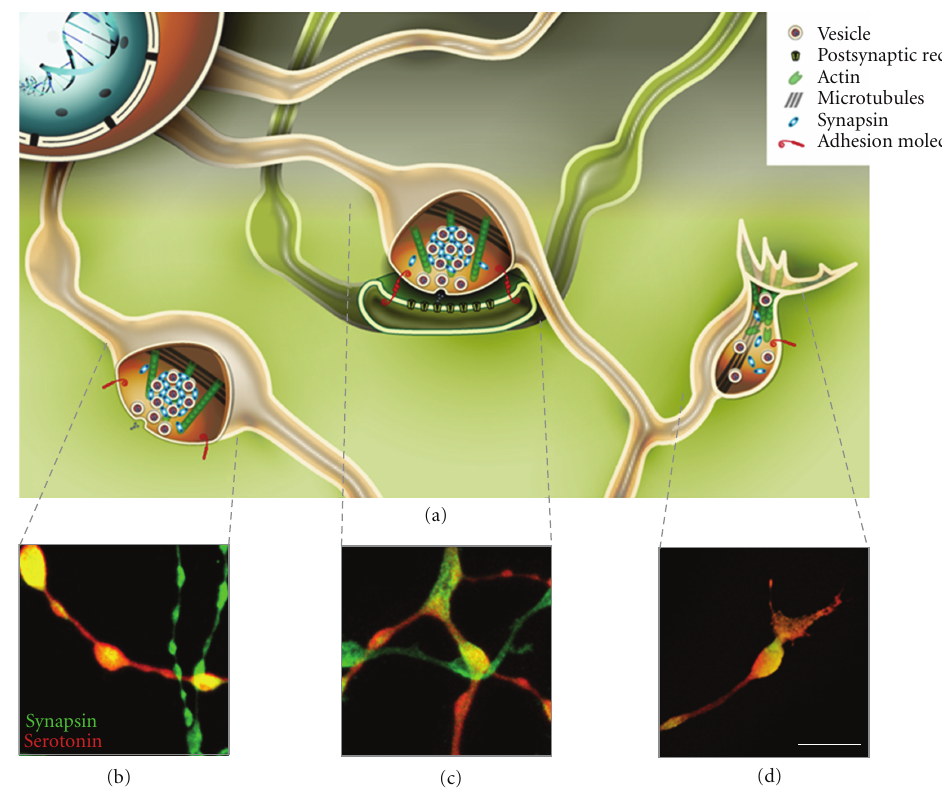
Figure 1: Schematic representation of the three most common types of varicosities observed in invertebrate neuronal cultures (a). The bottom panels show confocal acquisitions of neurites belonging to the serotonergic Helix neuron C1 cocultured with its physiological target B2 and immunostained with anti-serotonin (red) and anti-synapsin (green) antibodies. In these sample images it is possible to identify a varicosity without a postsynaptic target in which neurotransmitter release can be detected using functional dyes or electrophysiological techniques (b); a presynaptic varicosity interconnected with its postsynaptic counterpart (c); a newly formed varicosity derived from an advancing growth cone in which well-defined synaptic vesicle pools have not yet organized (d). Scale bar: 10 μ